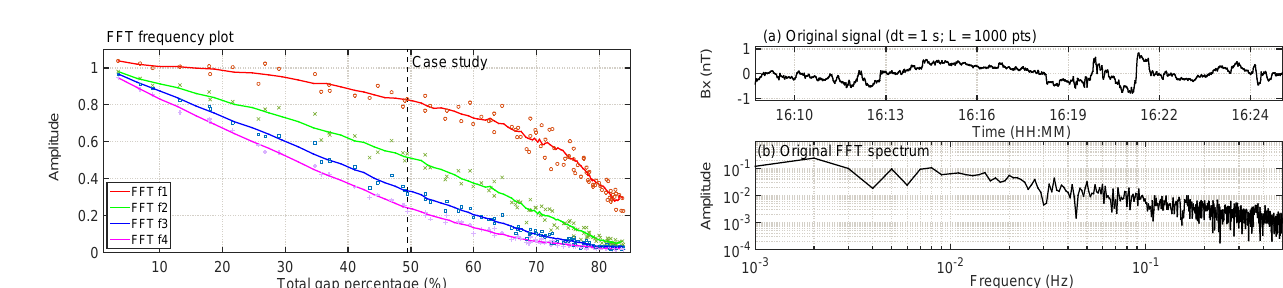
Figure 10. MSG test applied to the synthetic data: FFT amplitude as a function of TGP for the four frequencies of the synthetic signal: f 1 = 10Hz (red), f 2 = 20Hz (green), f 3 = 30Hz (blue) and f 4 = 40Hz (magenta). The thick lines are the average values, computed using a moving average filter with a span of 10 points.